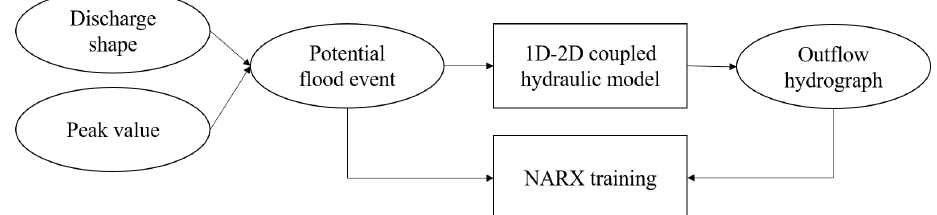
Figure 1. The proposed methodology to train the artificial neural networks that are capable of predicting outflow hydrographs of potential dike